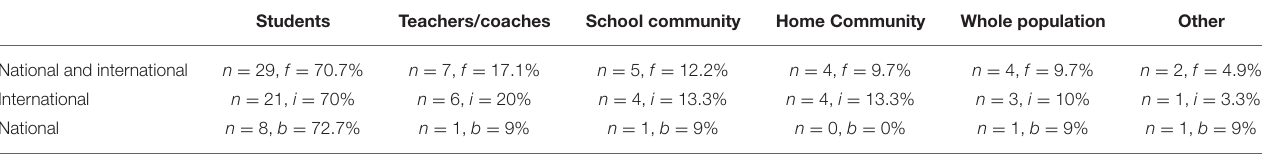
TABLE 5 | Target population of actions or research